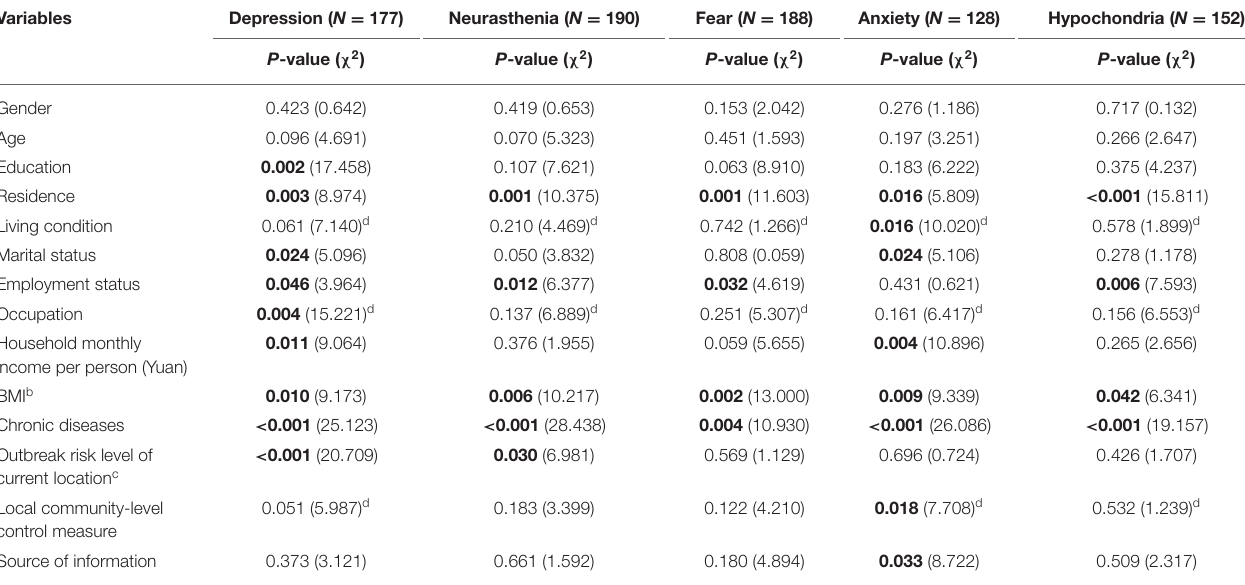
TABLE 3 | Univariate analysis of participants’ characteristics with the scores of the five sub-scales of the PQEEPH ( N = 1,278) a